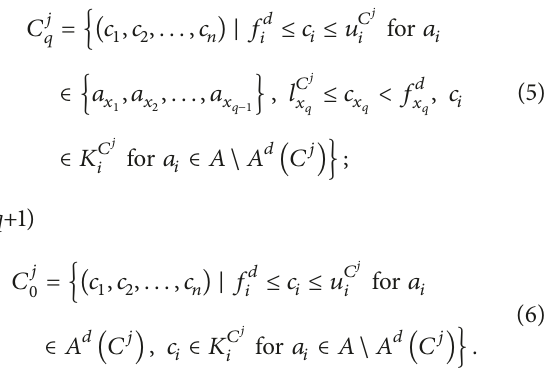
Algorithm A. Finding d -minimal paths in a multistate net-